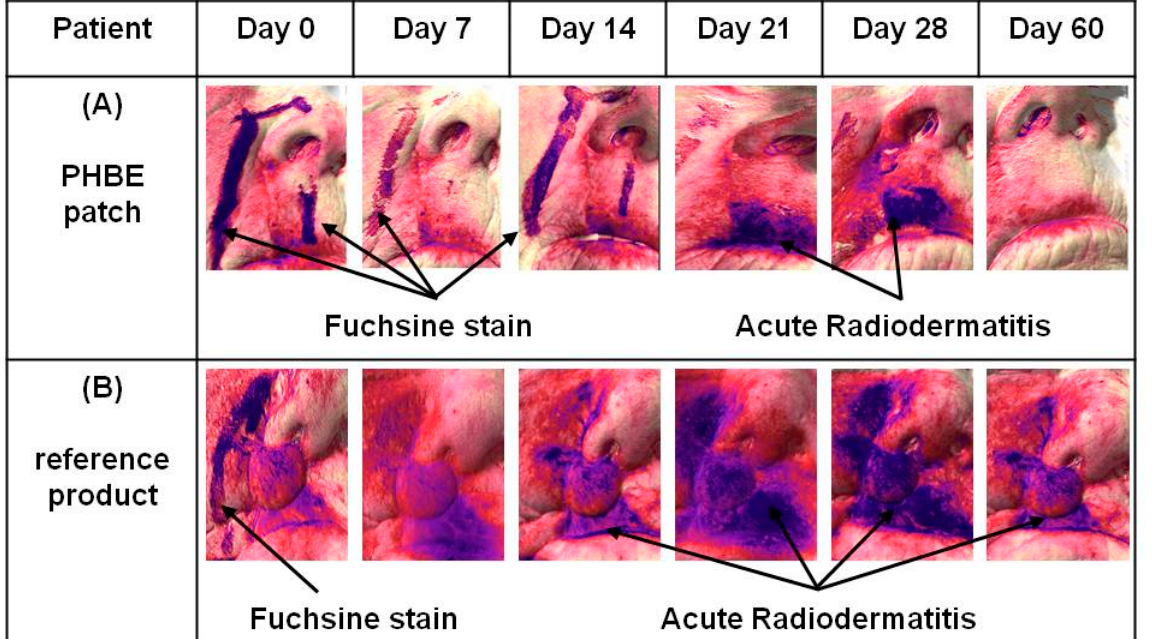
Figure 6. Representative Antera 3D images of ( A ) an 87-year-old female patient treating the alar nasal sulcus and upper lip area with a PHBE patch and ( B ) an 85-year-old female patient treating the alar nasal sulcus and upper lip area with the reference product before radiation (RT) (Day 0); during Days 7, 14, 21, and 28; and 1 month after RT (Day 60). In contrast to the reference cream, the PHBE patch demonstrated significant anti-inflammatory efficacy and skin recovery 1 month after RT (Day 60).